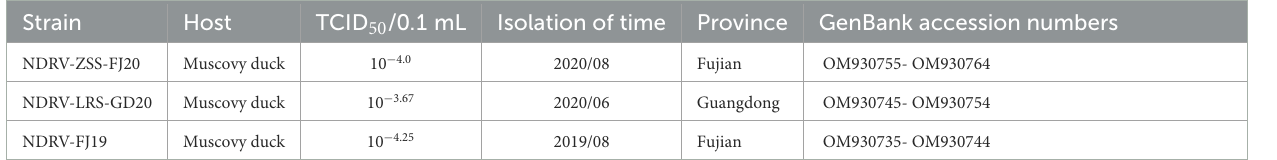
TABLE 2 Information on three novel duck reovirus